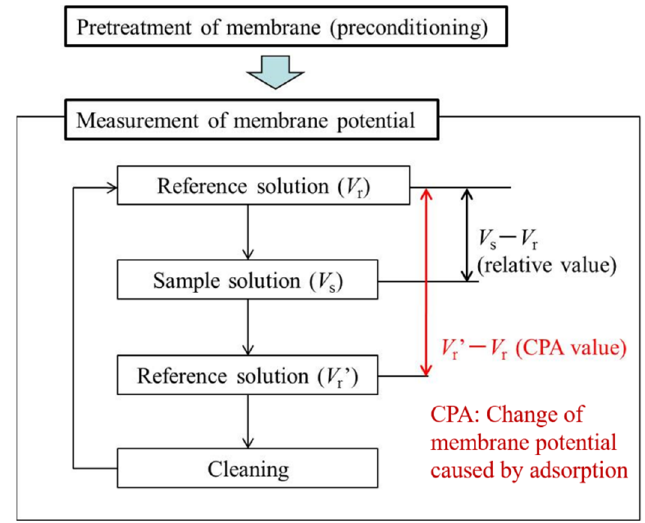
Figure 4. Measurement procedure using taste sensor.